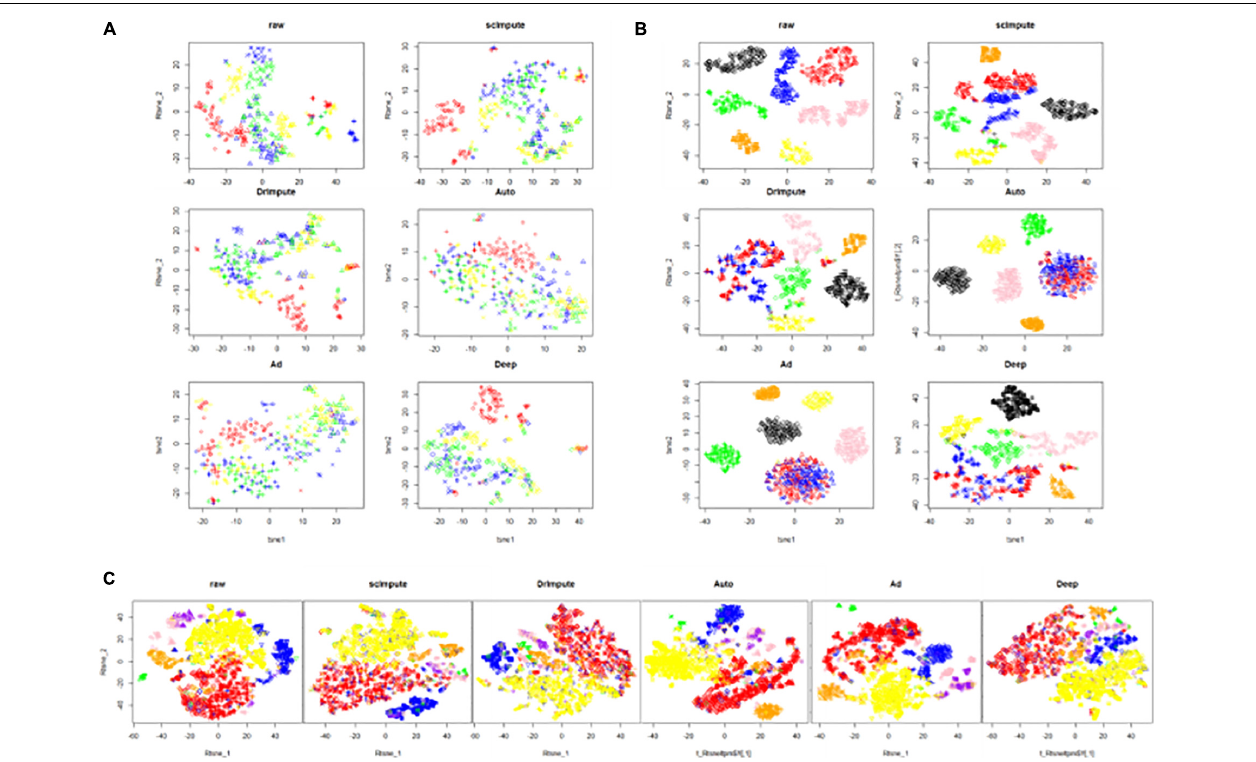
FIGURE 7 | The visualization results of clustering on the real data sets. The six images are the clustering results of the raw data and the clustering results imputed by scImpute, DrImpute, AutoImpute, AdImpute, and DeepImpute. And (A) is the clustering visualization results on Trapnell (GSE52529) data set; (B) is the clustering visualization results on hPSC (GSE75748) data set; (C) is the clustering visualization results on Romanov (GSE74672) data